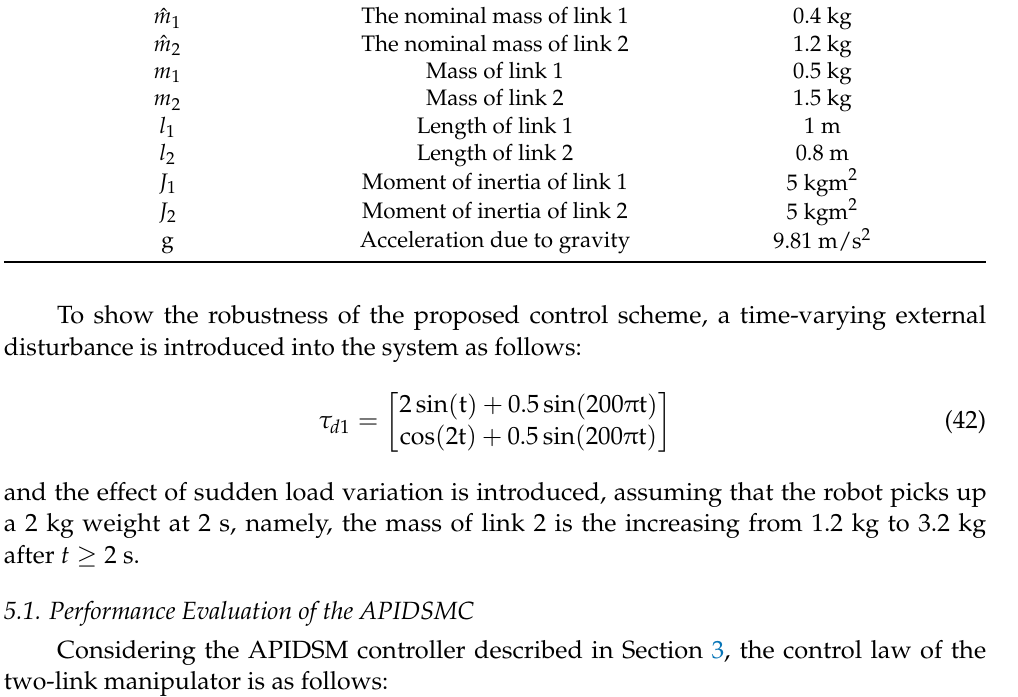
Table 1. Physical parameters of the robotic manipulator used in the simulation.